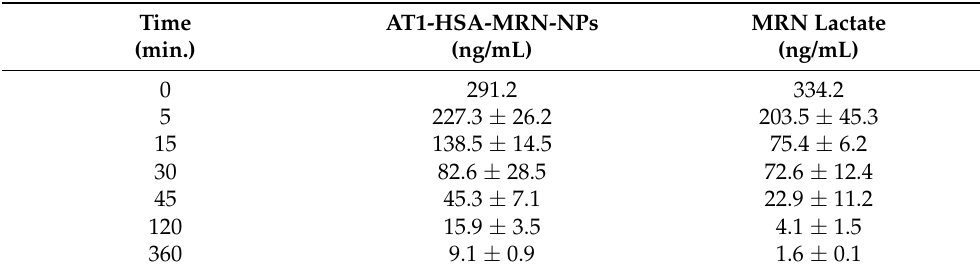
Figure 5. Pharmacokinetics of AT1-HSA-MRN-NPs (Group II) and MRN-Lactate (Group III) at an initial MRN dose of 50 µ g/kg in vivo. Table 2. Comparing milrinone concentration (ng/mL) at various time points between AT1-MRN- HSA-NPs (Group II) and MRN Lactate (Group III) injected intravenously in female Lewis rats. Table shows a representative result of mean ± SD ( n = 4).